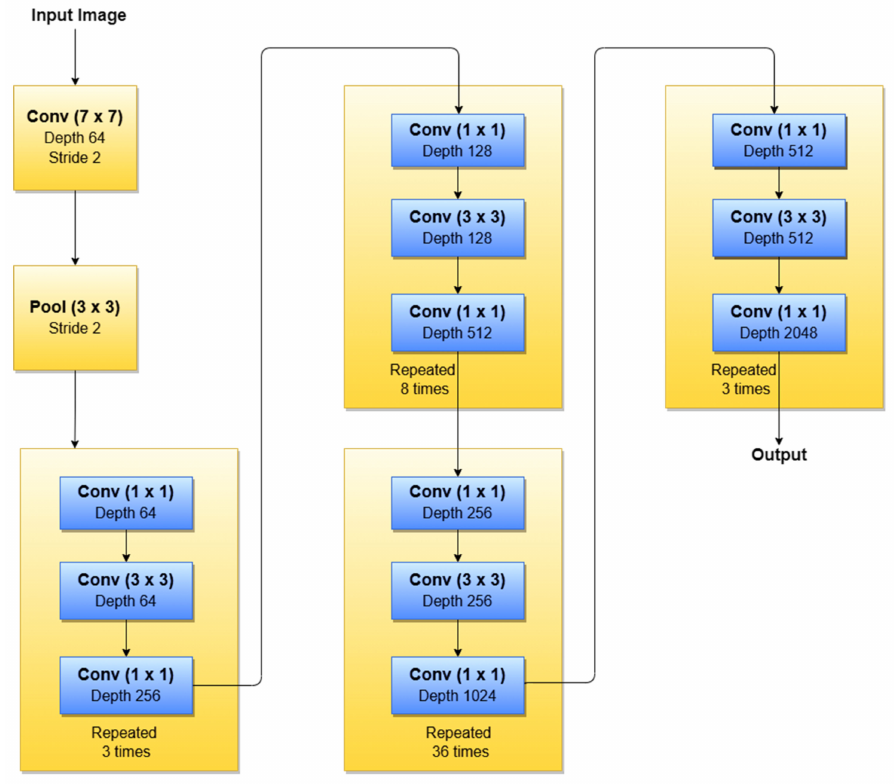
Figure 16. ResNet-152 basic